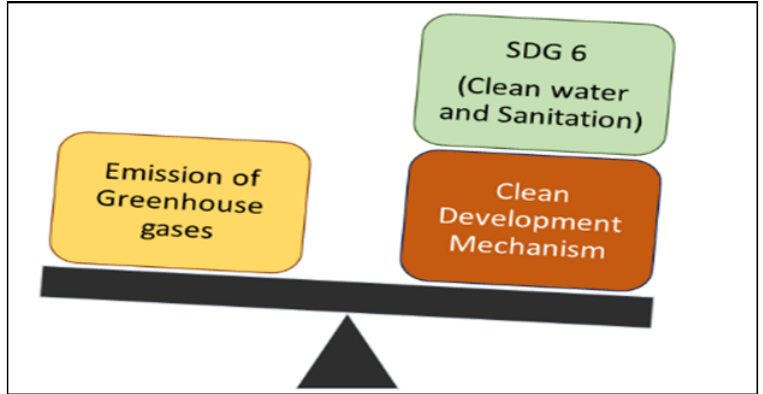
Figure 2. Strategies to reduce emissions of GHGs from Indian freshwater ecosystems.